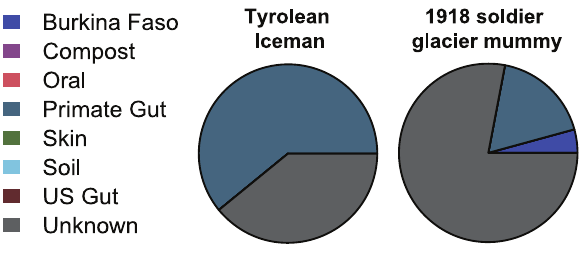
Figure 4. Bayesian source-tracking results for the Tyrolean Iceman and a 1918 soldier glacier mummy (sequence data published in [ 19 ] ). The Tyrolean Iceman sample exhibits a substantial degree of similarity to a primate gut, while the soldier mummy assigns mostly to an unknown microbial community, within minor and low- confidence proportions assigning to the primate gut and rural African child gut sources (See Figure S6 for variability in proportion estimates).